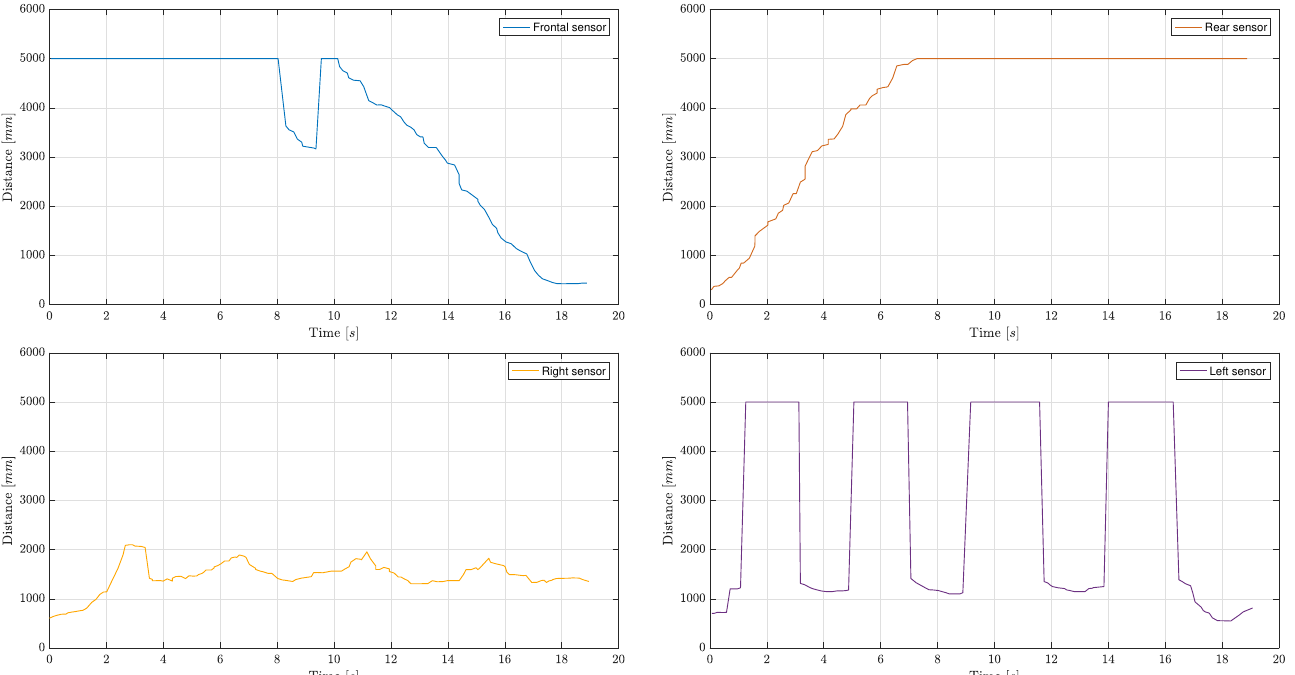
Figure 12. Distance estimates detected with the ultrasonic sensors’ configuration shown in Figure 8, during a walk inside the “Santa Elisabetta” Congress Center of the University of